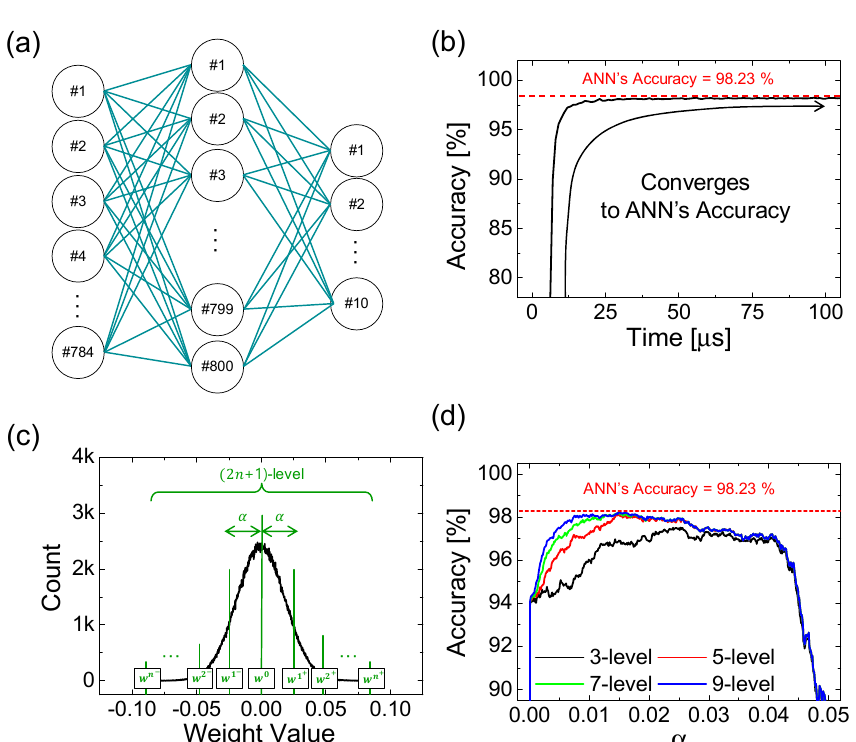
Figure 2. ( a ) Trained neural network for MNIST dataset consisting of 784, 800, and 10 neurons in the input, hidden, and the output layers; ( b ) Time-accuracy of spiking neural network (SNN) according to the simulation time; ( c ) Full-precision weight distribution; ( d ) The optimization process of the weight quantization according to the weight interval α .